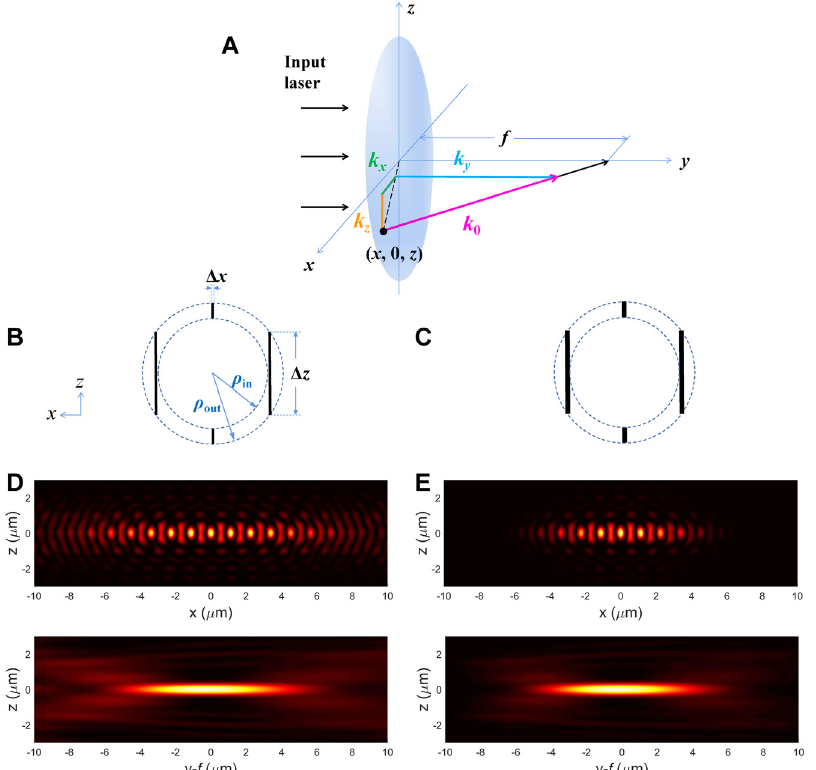
Figure 1: (A) Wavevector components k x , k y , k z of a refracted light contributed by a light wave at ( x , 0, z ) on a lens. (B) & (C) Pupil functions for square lattice light-sheets in (D) & (E), respectively. A laser beam transmits through the black slit located on the back focal plane of the objective lens. (D) & (E) Simulated xz and yz cross- sectional intensity distributions of the squarelatticelight-sheetsgeneratedby(B) & (C),